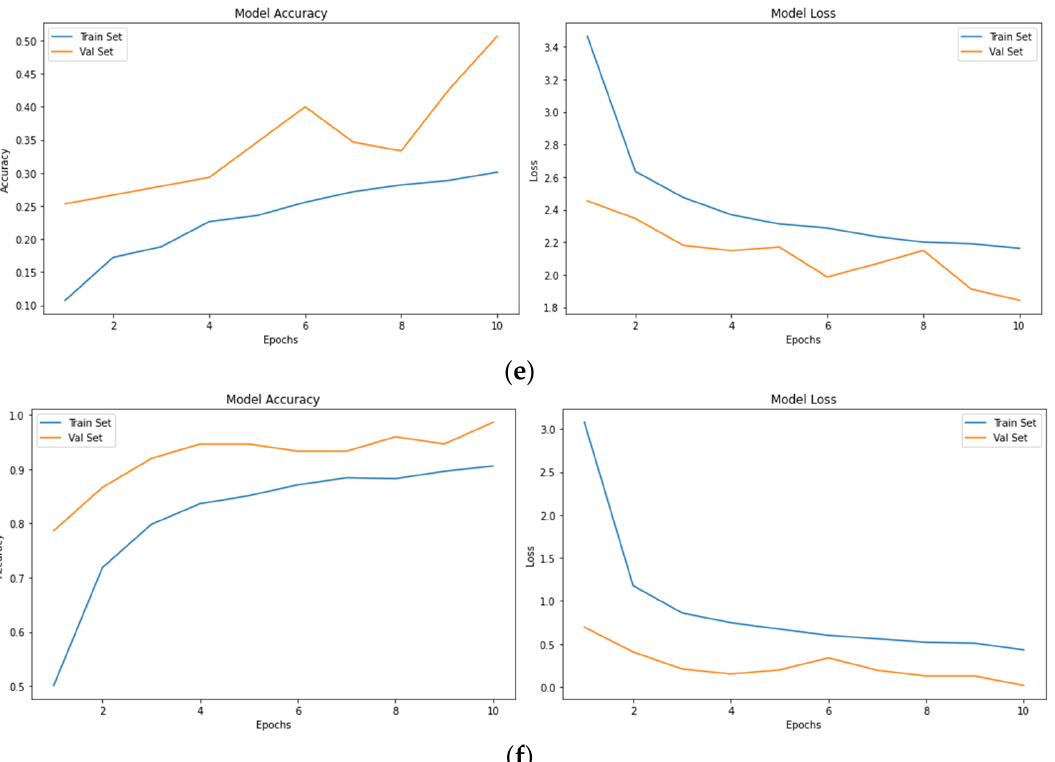
Figure 3. ( a ) Accuracy and Loss values of VGG16 Model. ( b ) Accuracy and Loss values of VGG19 Model. ( c ) Accuracy and Loss values of MobileNet Model. ( d ) Accuracy and Loss values of Xception Model. ( e ) Accuracy and Loss values of ResNet50 Model. ( f ) Accuracy and Loss values of Inception V3 Model.